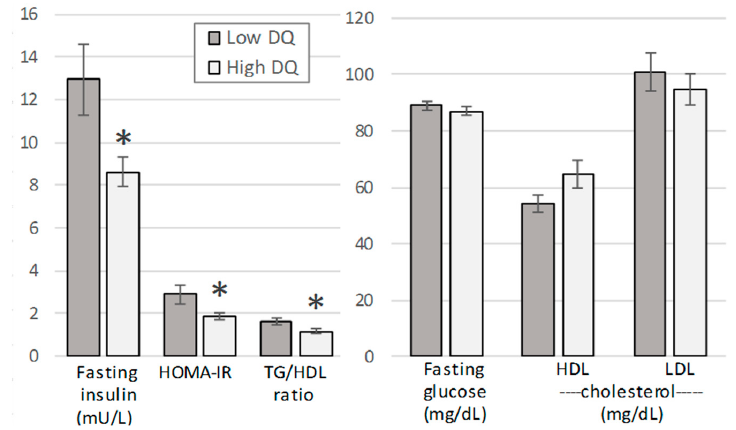
Figure 1. Selected blood biomarkers for diet quality (DQ) groups (low DQ, Rapid Eating and Activity Assessment for Participants Short Version (REAP-S) scores < 37; high DQ, REAP-S scores ≥ 37). Means (±SE) differed significantly by diet quality group ( p = 0.042, multivariate test; asterisks indicate the significant differences between low and high diet quality groups following post-hoc analysis).